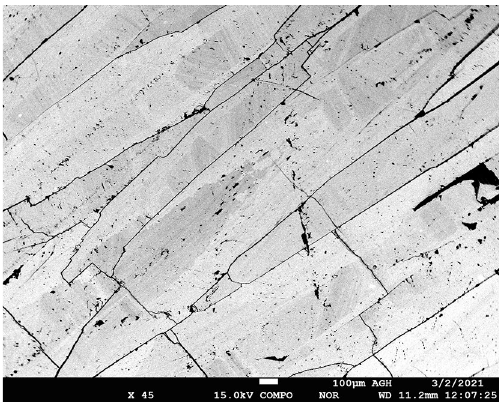
Figure 8. BSE image of barite crystal showing chemical zonation.